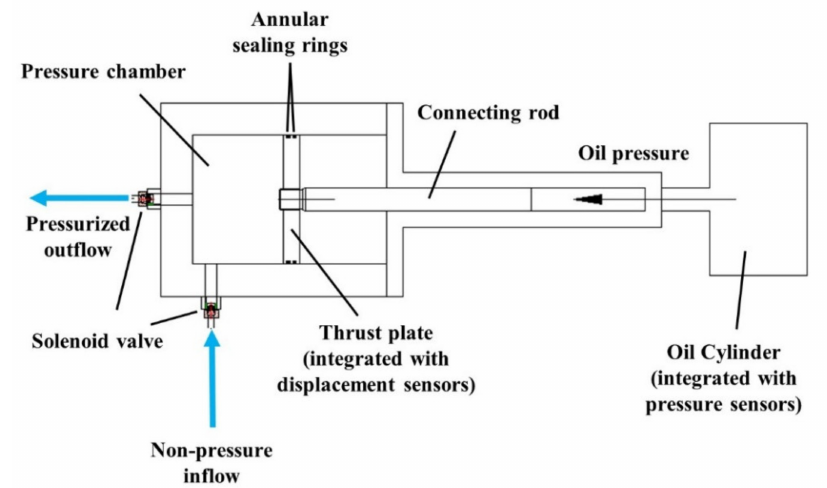
Figure 4. Schematic design of the pressure